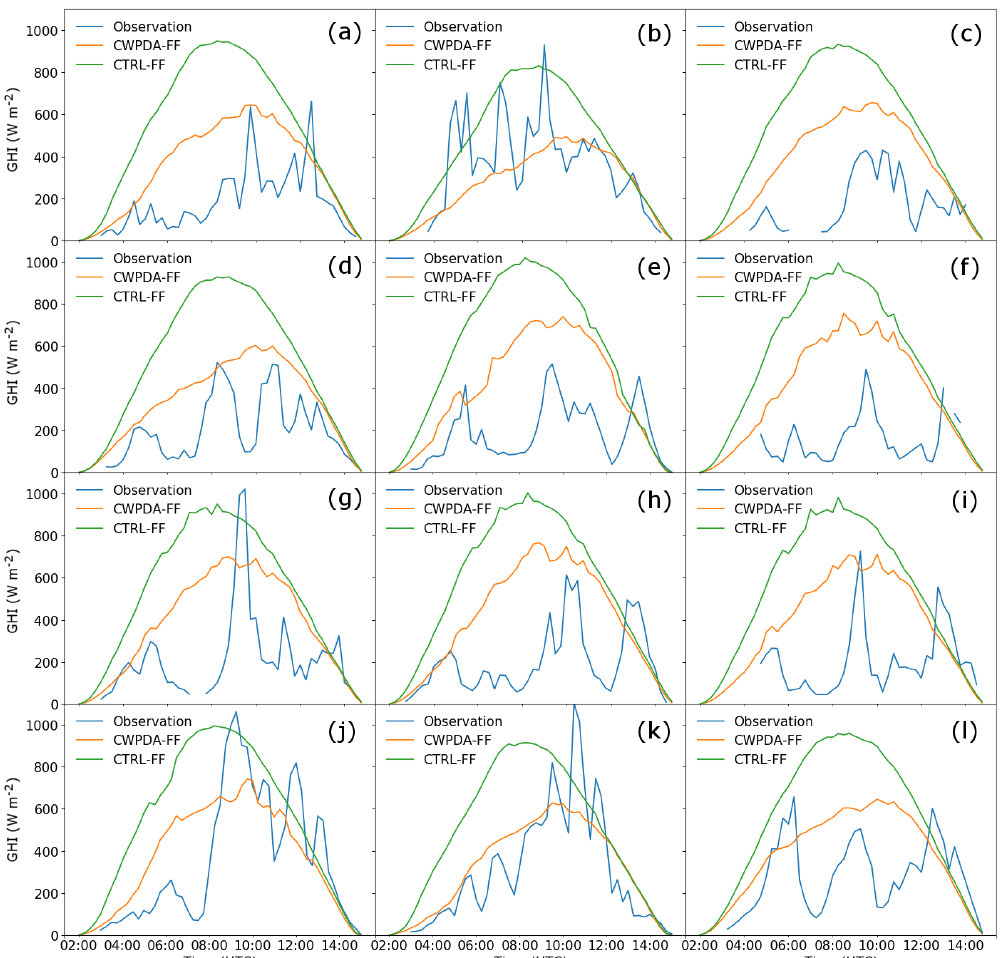
Figure 8. GHI on Réunion Island on 12 January 2018 as observed (blue) and forecasted by CWPDA-FF (orange) and CTRL-FF (green) with IDW post-processing for the sites Plaine des Cafres (a) , Gros Piton Sainte-Rose (b) , Cilaos (c) , Bellevue Bras-Panon (d) , Le Port (e) , Colimaçons (f) , Piton–Maido (g) , Pointe des Trois-Bassins (h) , Petite-France (i) , Pierrefonds-Aéroport (j) , Le Baril (k) , and Gillot- Aéroport (l) .